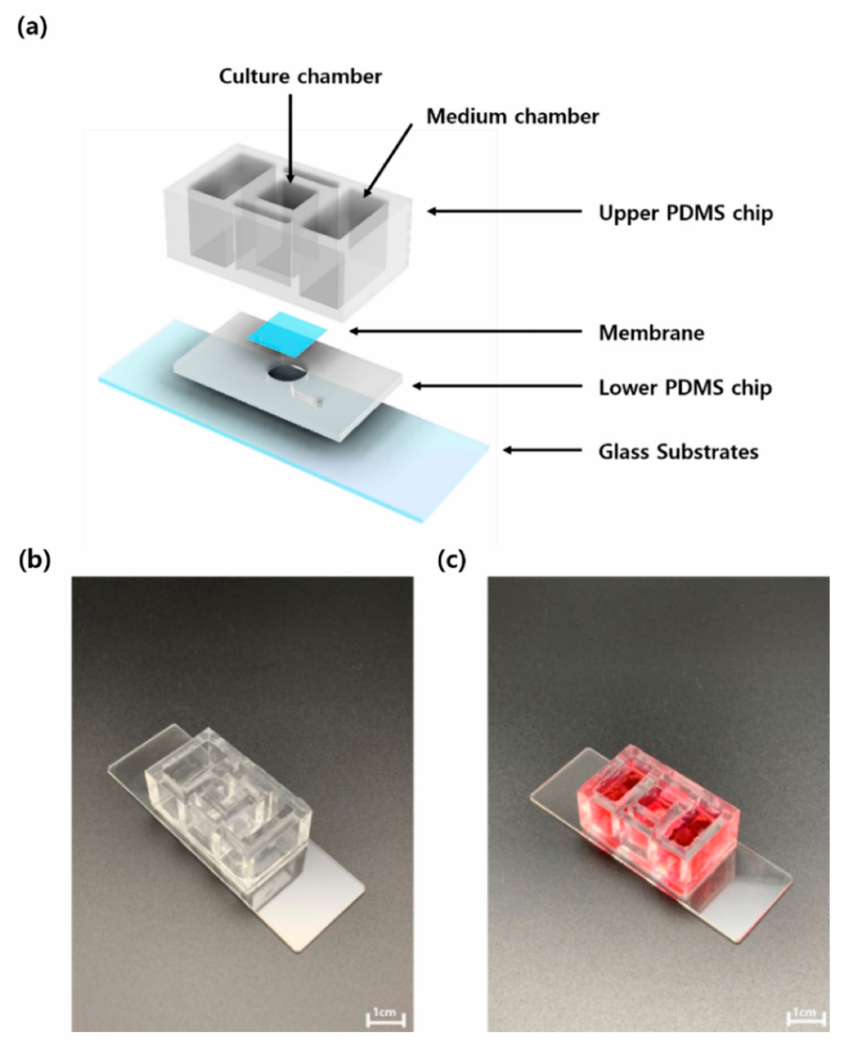
Figure 8. Schematic diagram of ( a ) the structural description of flexible skin-on-a-chip (FSOC), ( b ) actual photograph of FSOC and ( c ) actual photograph when medium is put in